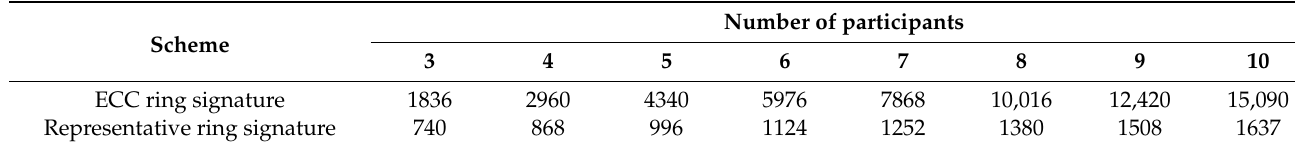
Table 2. A comparison of signature sizes of two schemes.